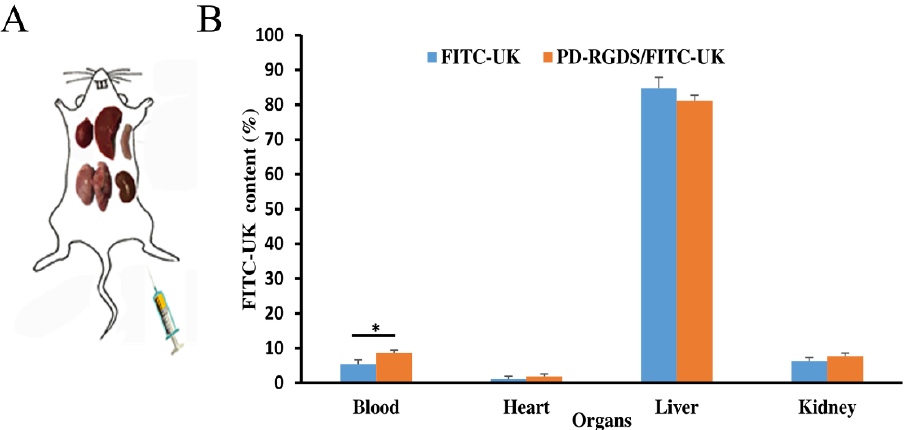
Figure 6. The assay on organ distribution. ( A ) The model of organ distribution study. ( B ) Organ distribution of FITC-UK/PD-RGDS complex and FITC-UK in vivo (n = 5). * p < 0.01.